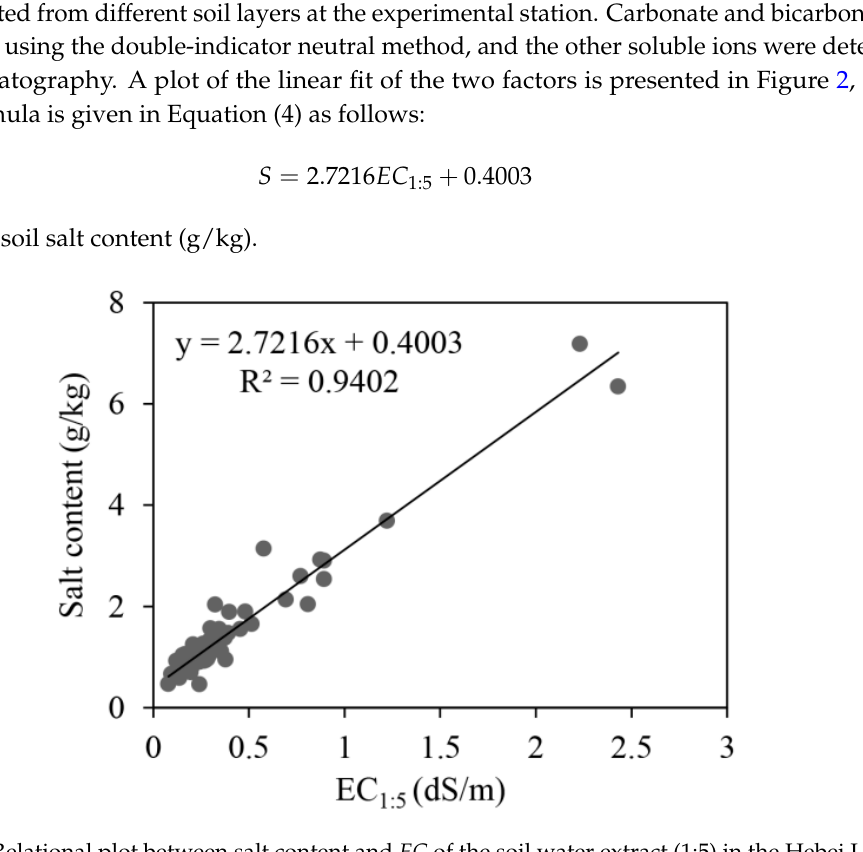
Figure 2. Relational plot between salt content and EC of the soil water extract (1:5) in the Hebei Low Plains study area in North China.